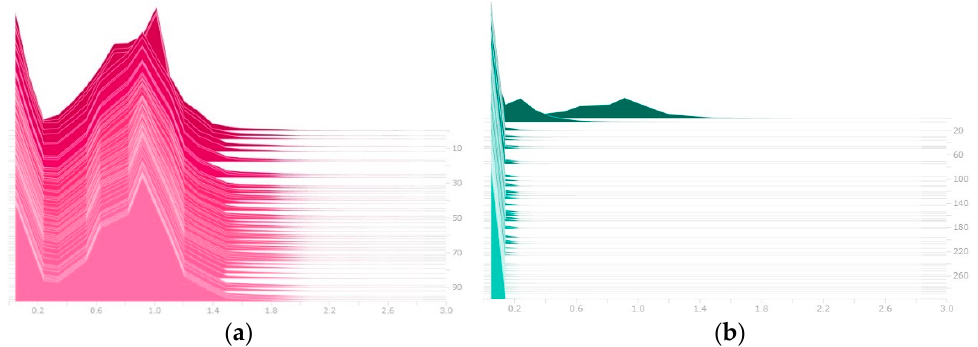
Figure 11. Distribution of trainable weight. ( a ) Trainable weight before sparsity training. ( b ) Trainable weight after sparsity training.